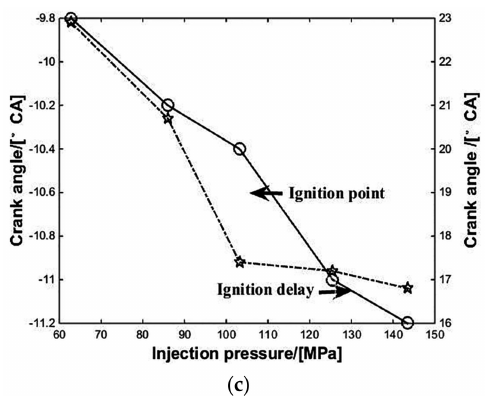
Figure 2. Effects of different injection parameters on the combustion parameters. ( a ) Different pre-injection timings; ( b ) Different main-injection timings; ( c ) Different injection